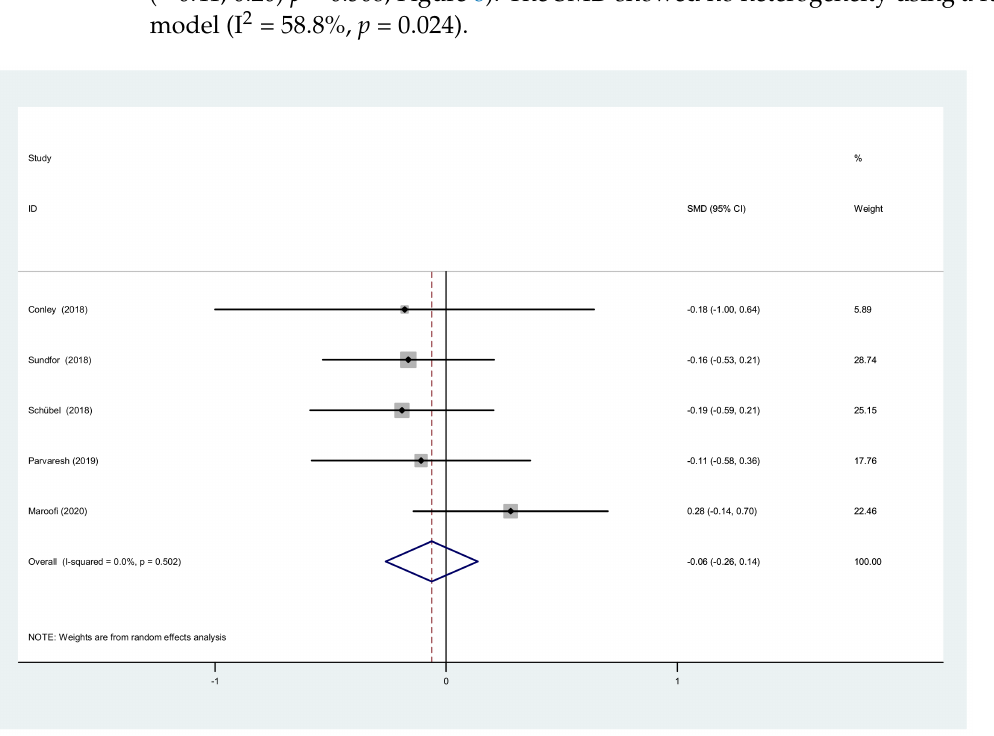
Figure 6. Forest plot of meta-analysis on comparing TC changes after IF and CCR interventions.